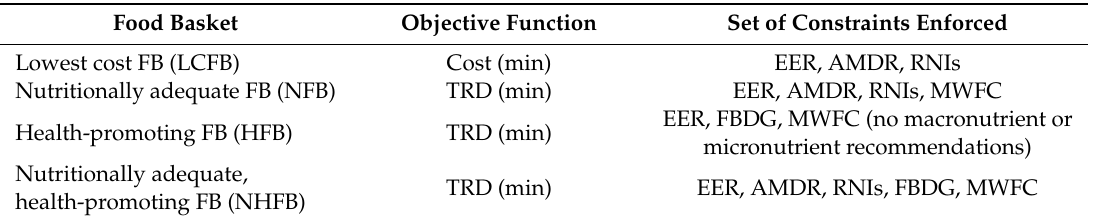
Table 3. Abbreviations used for the models describing the di ff erent optimised food baskets by objective functions and constraints enforced. Food Basket Objective Function Set of Constraints